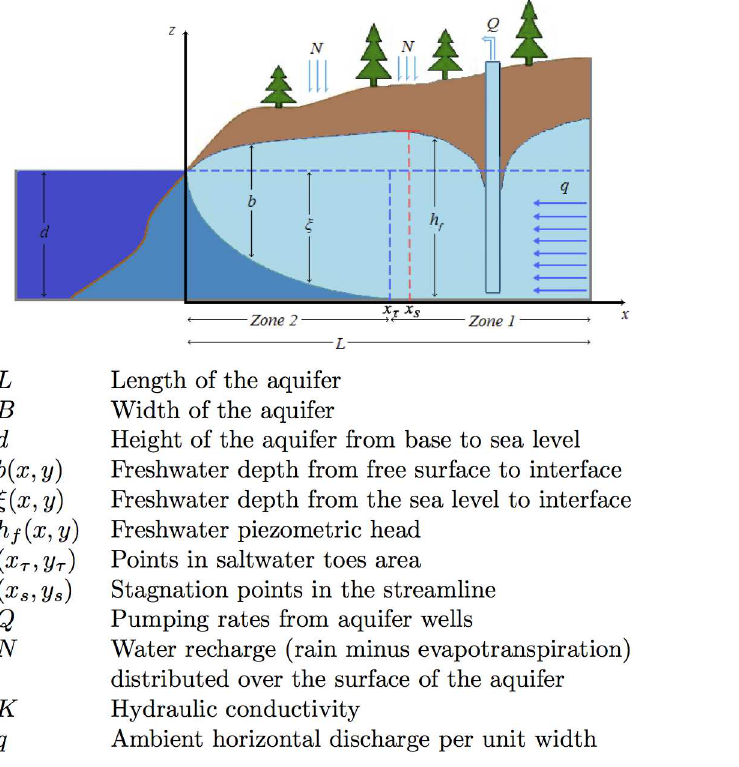
Fig 2. Cross section of a coastal freshwater aquifer.